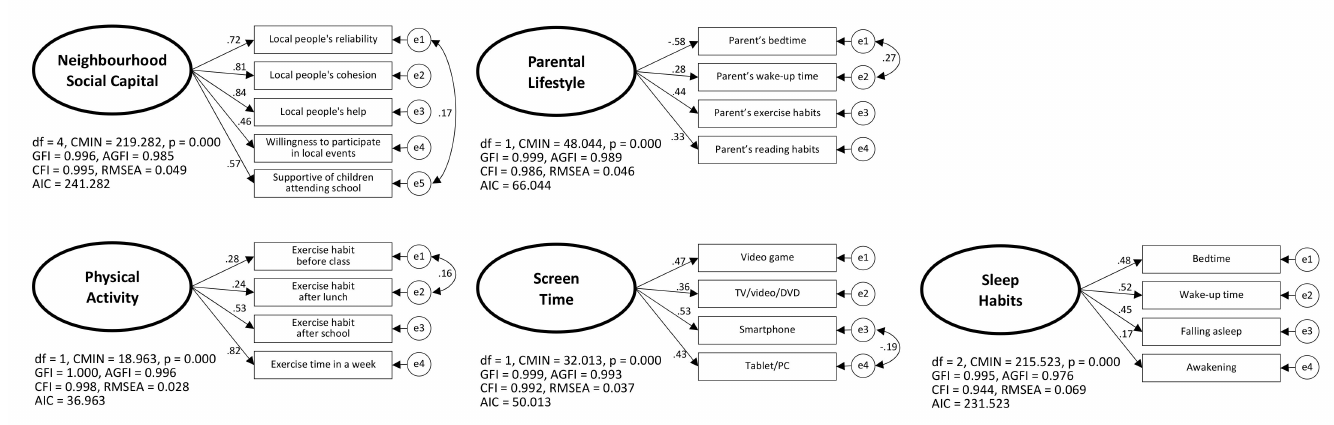
Figure 2. Confirmatory factor analysis of each latent